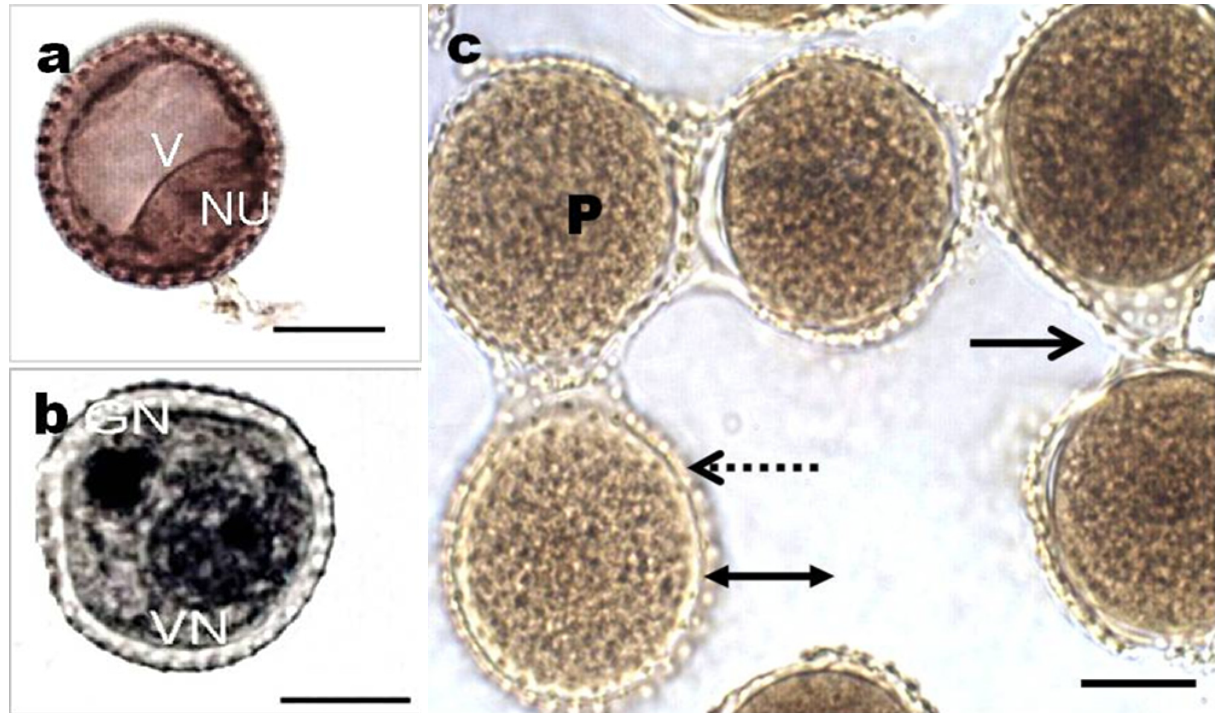
Fig. 7. a. Pollen with a large vacuole and nucleus displaced to one side, Bar 10 μm ; b. Mature pollen grain with 2-celled, a generative cell and a vegetative cell at the shedding time, Bar 10 μm ; c. Pollen unifying due to the wall bridges (→) and exine (--->) and intine ( ↔ ), Bar 10 μm . V-Vacuol; NU-Nucleus; VN-Vegetative nucleus; GN-Generative nucleus;